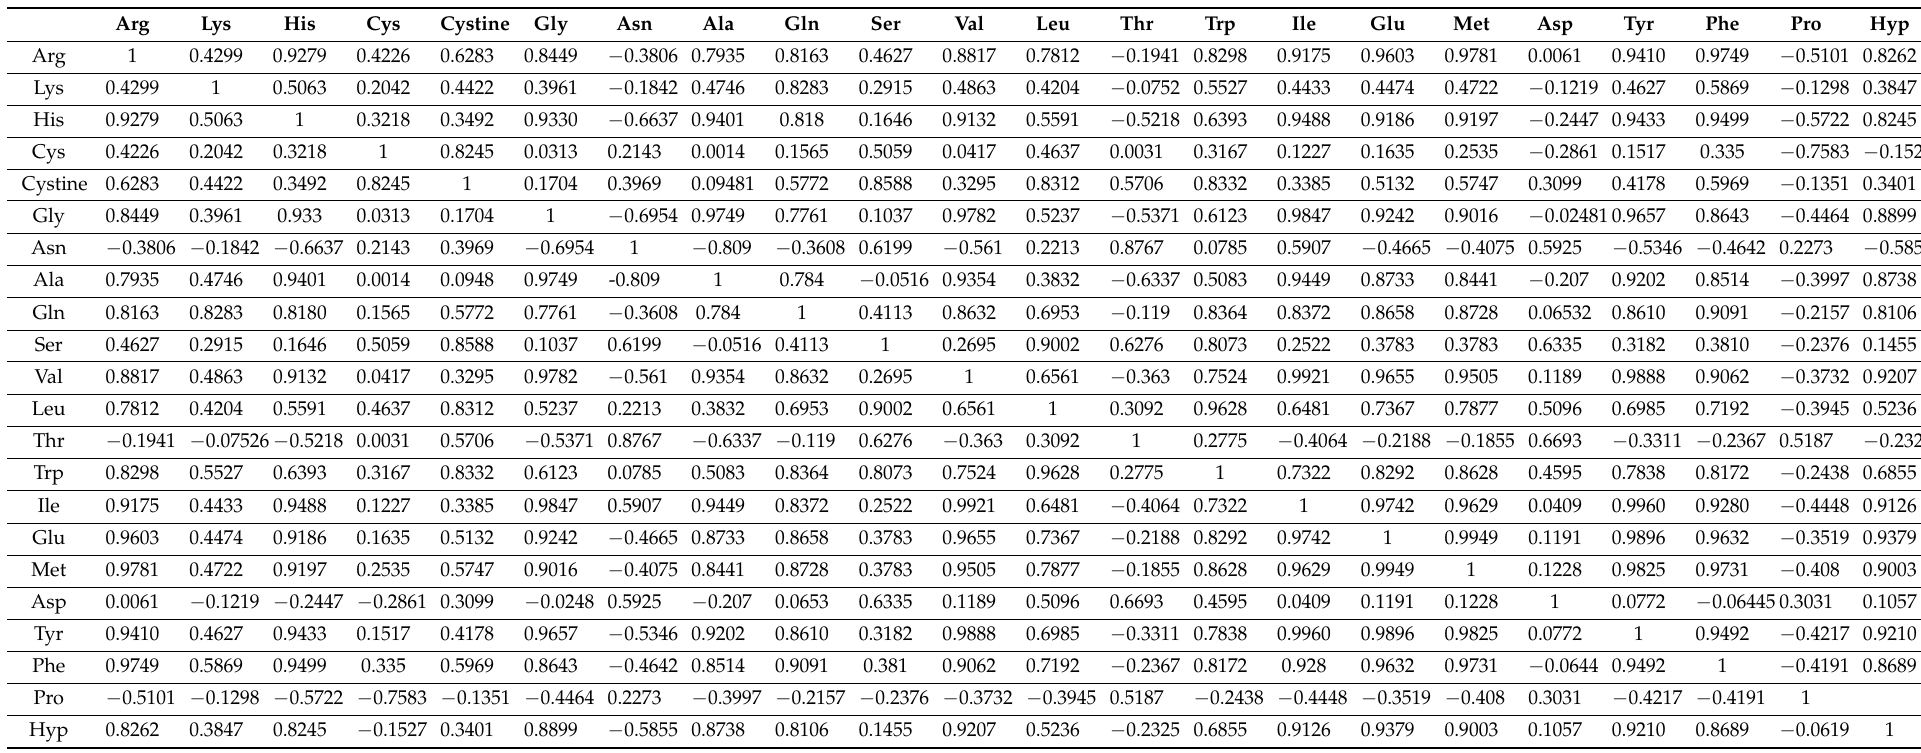
Table 3. Pearson correlation of amino acid content in resultant Feteasc ă regal ă